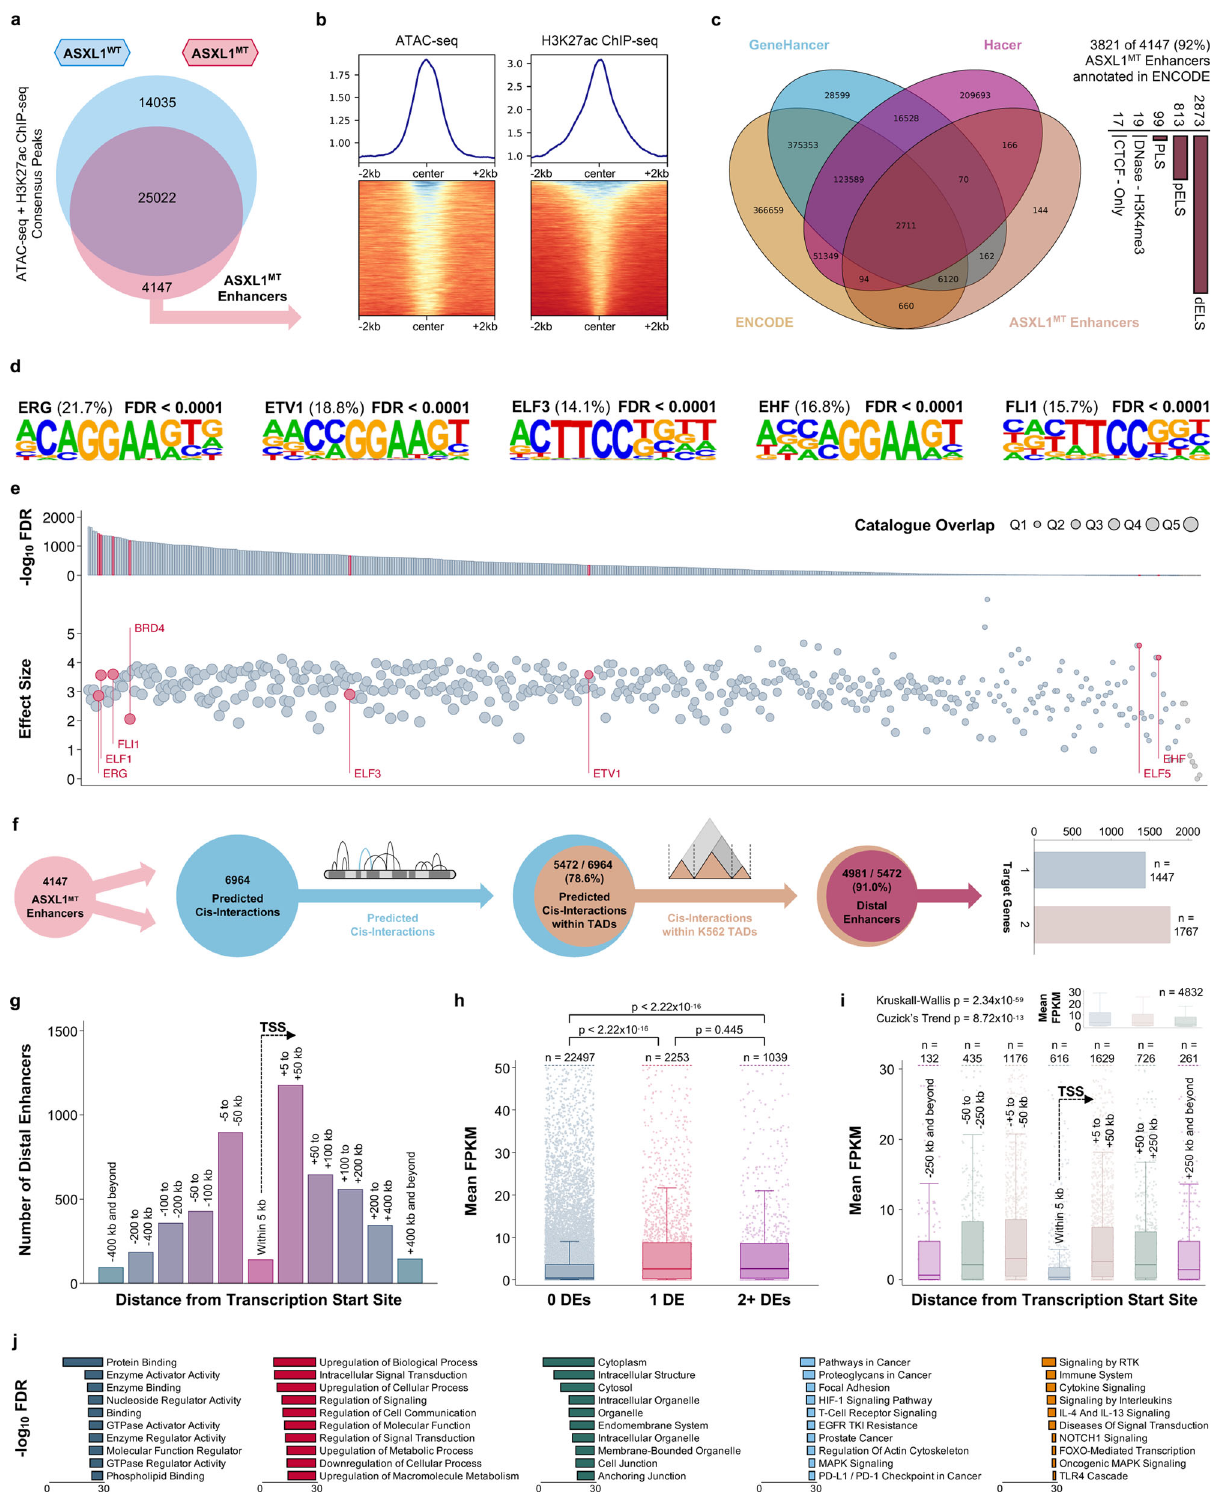
cells con fi rms the results generated from CD14-sorted monocytes 45 . Avoiding excessive cell attrition due to sorting, we have been able to perform all analyses with at least fi ve biological replicates per group. There were 16 patients included in this study and we performed experiments on all available samples for these patients. Supplementary Fig. 1c shows the samples that were included in the analysis after performing sample and data quality control. There were 14 samples for RNA-seq (87.5%), 15 for H2AK119ub ChIP-seq (93.8%), 15 for H3K27ac ChIP-seq (93.8%), 12 for H3K27me3 (75.0%), 14 for H3K4me1 ChIP-seq (87.5%), 11 for H3K4me3 ChIP-seq (68.8%), 15 for 5mC DIP-seq (93.8%), 15 for